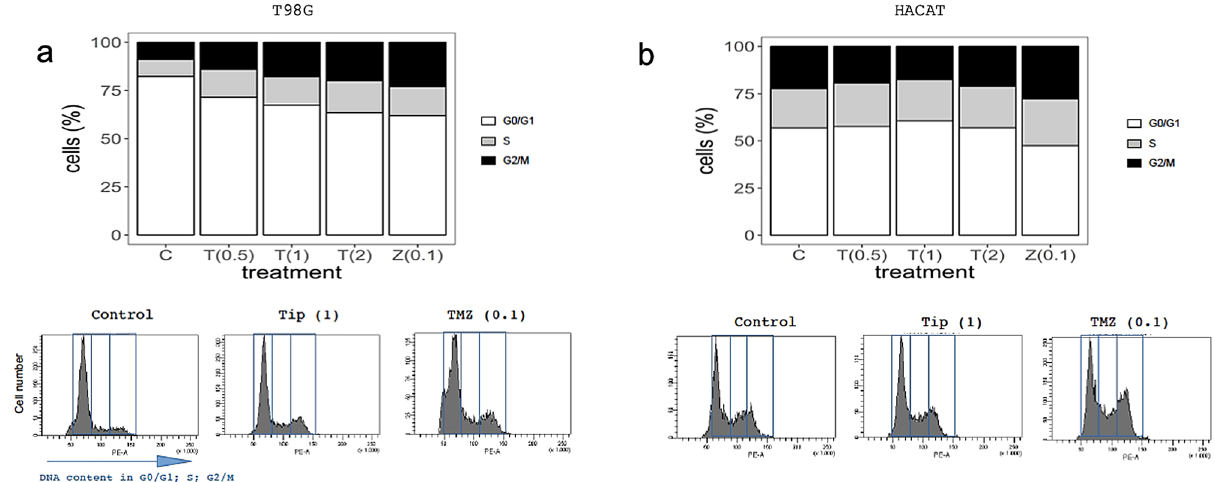
Figure 5. Cell cycle study. ( a ) Bar graphs illustrate results of T98G cell cycle analysis, indicating the percentage of cells in the G0/G1, S, and G2/M cell cycle phases following 24 h treatment with concentrations of 0.5, 1, and 2 mg/mL DAV and with TMZ at 0.1 mg/mL. Below, representative histogram plots of cell cycle distribution showing DNA content in each phase. ( b ) The same analysis as ( a ) is shown for HACAT cells. Values in brackets stand for compound concentration in mg/mL. Linear mixed models to assess the effects of treatments were used as described in Fig. 1. Data are means ± SEM (n =